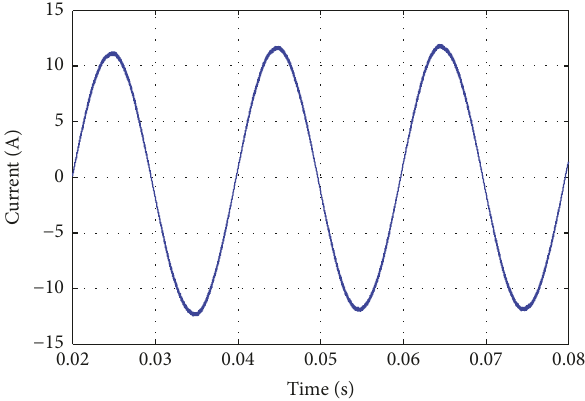
Figure 3: Output current of the DC/AC grid connected